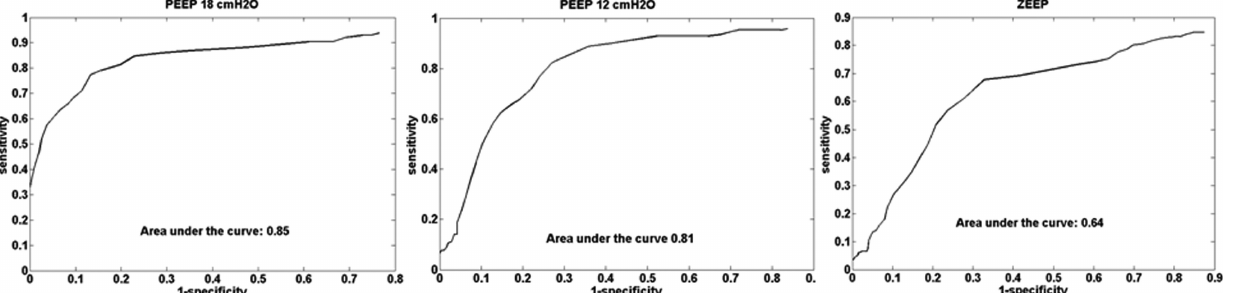
O, 12 cm H O and 2 2